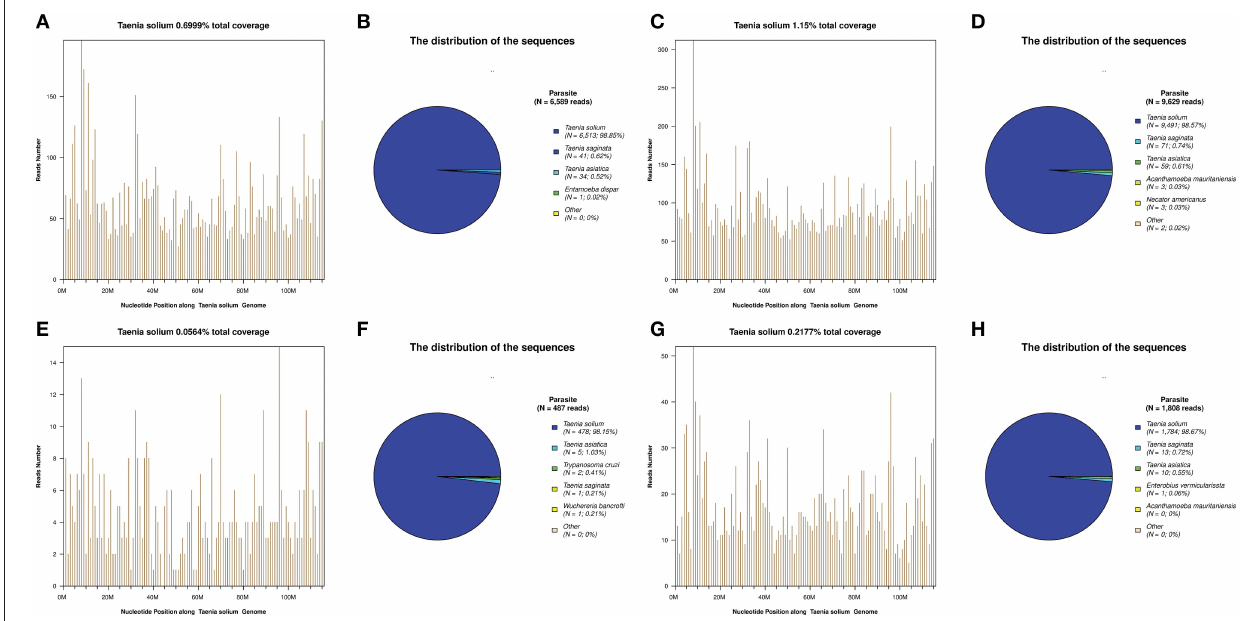
FIGURE 2 | Next-generation sequencing (NGS) of cerebrospinal fluid (CSF) results for the patients. T. solium DNA sequences were detected in the CSF samples of all patients (A–H) . The identified sequence reads corresponding to T. solium were 6,513 (B) , 9,491 (D) , 478 (F) , and 1,784 (H) ; with a genomic coverage of 0.70% (A) , 1.15% (C) , 0.06% (E) , and 0.22% (G) , for case 1, 2, 3, and 4, respectively. A few reads aligned to other members of the genus Taenia , including T. saginata and T. asiatica (B,D,F,H)